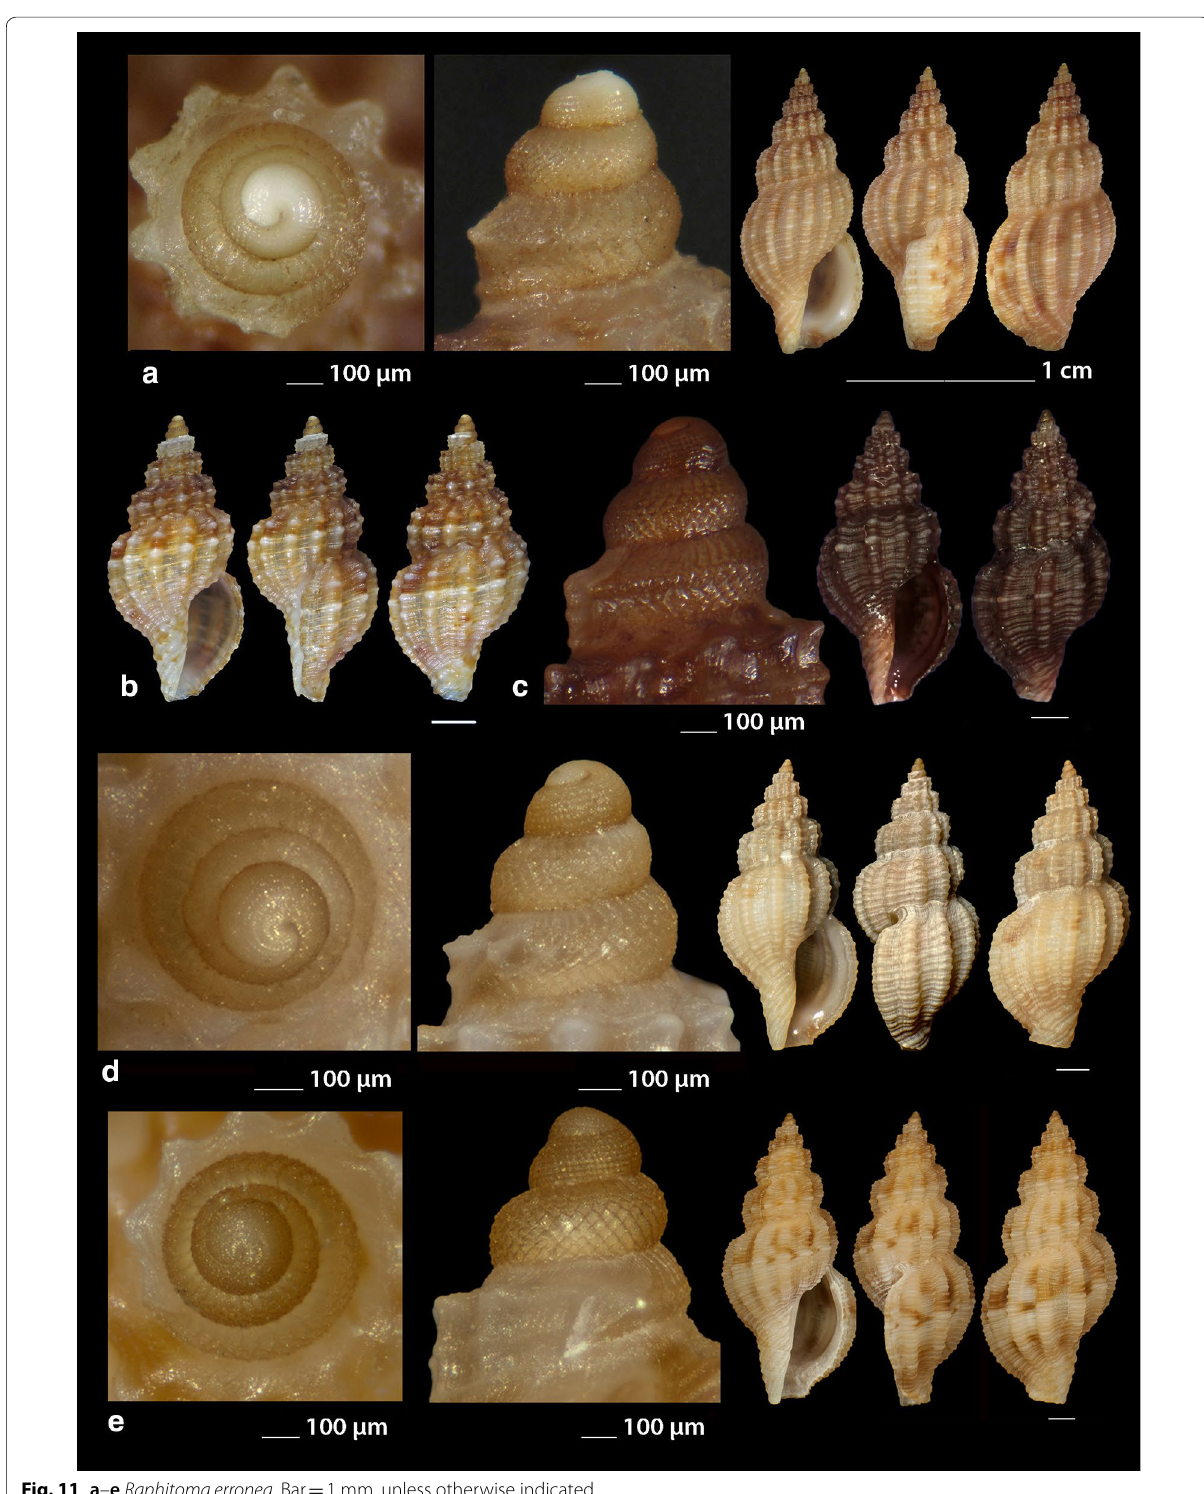
Fig. 11 a – e Raphitoma erronea . Bar